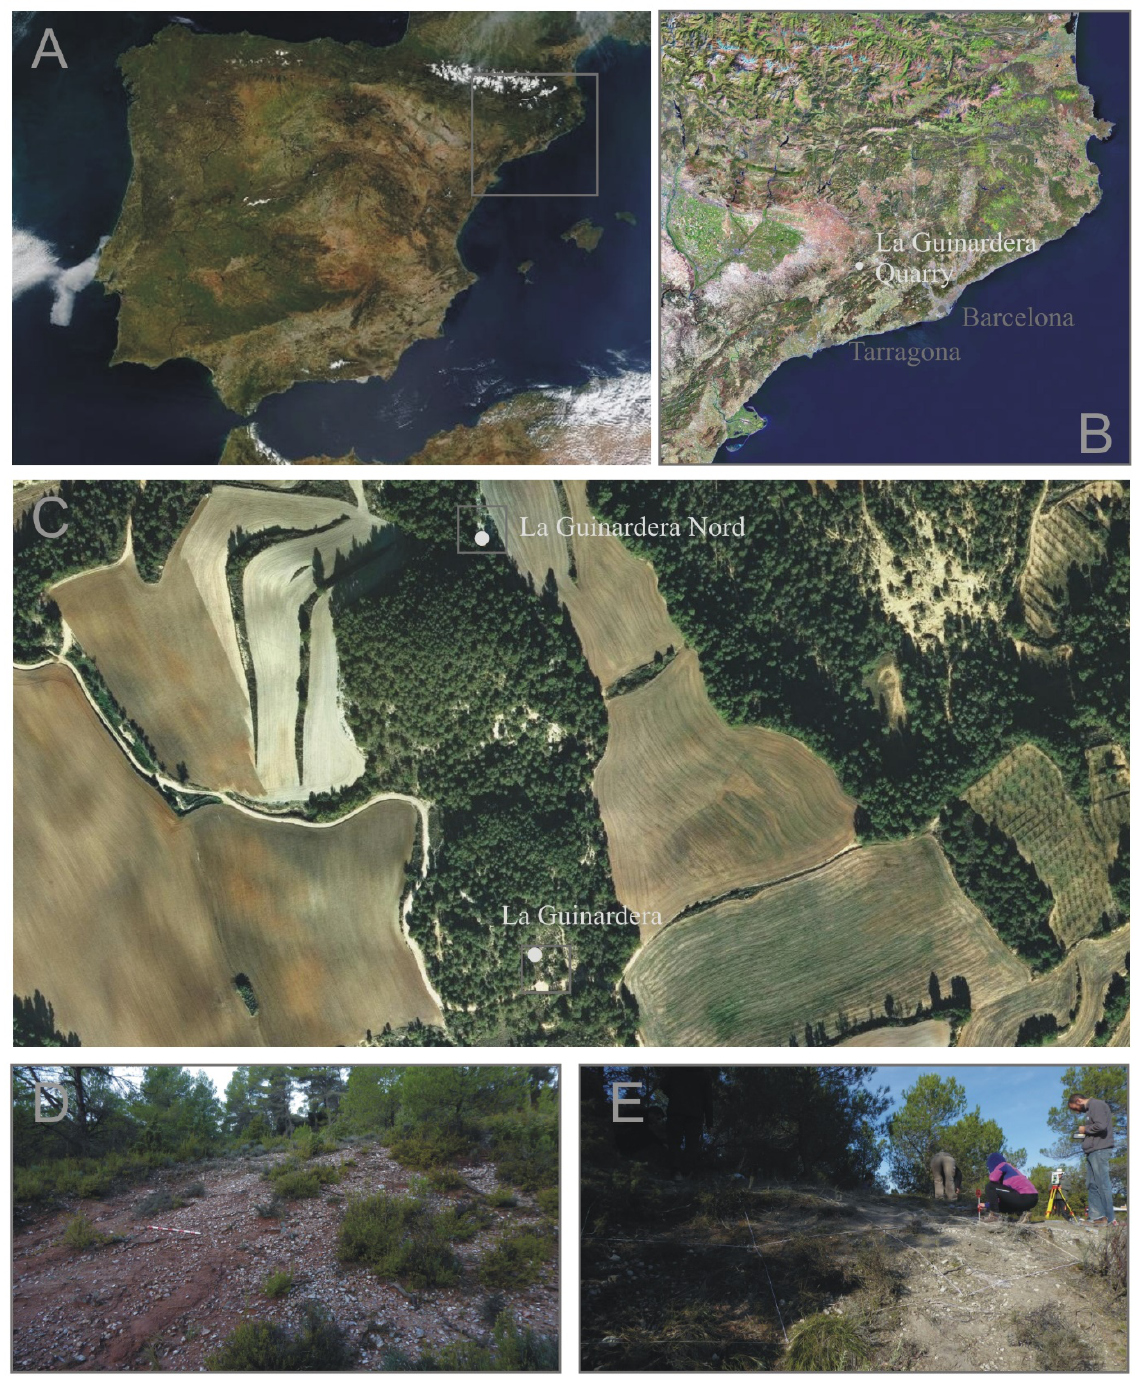
Figure 1. A and B) Location of La Guinardera Quarry in the Iberian Peninsula and the Catalonian region. C) The two workshops in an orthophotomap. D) La Guinardera Workshop. E) La Guinardera Nord